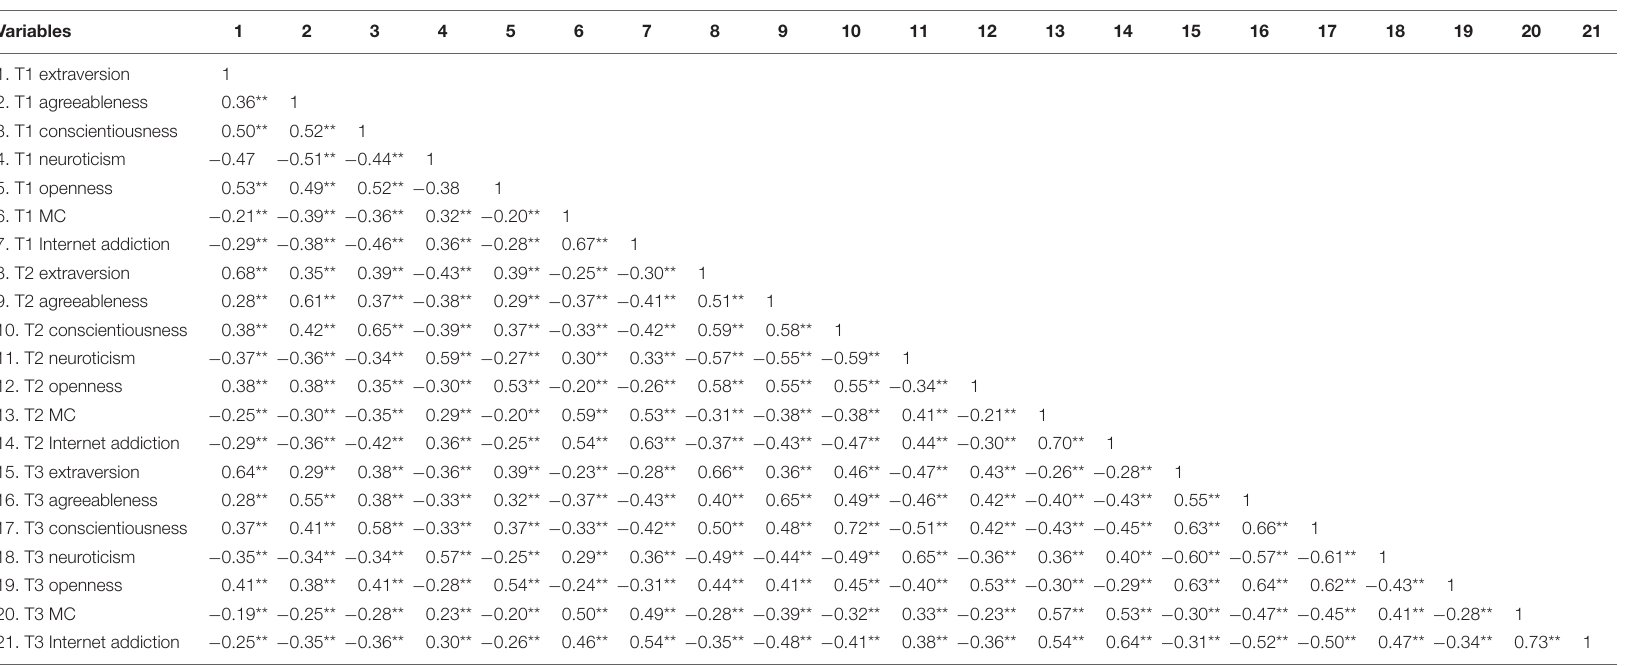
TABLE 1 | The associations among the Big Five personality traits, maladaptive cognitions, and Internet addiction across time.